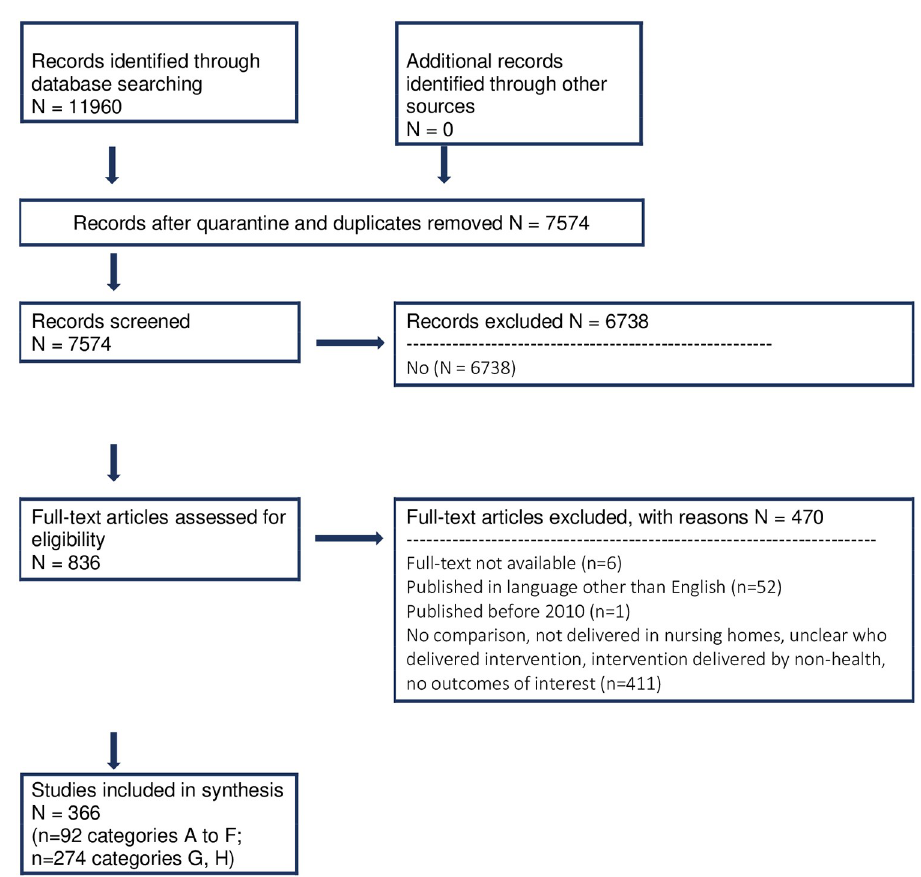
Fig 1. PRISMA flow diagram. Fig 1 presents the flow (inclusion/exclusion) of the studies through the stages of study selection.